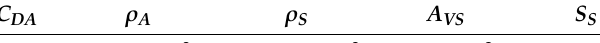
Table 5. Factors for calculating the air resistance coe ffi cient.